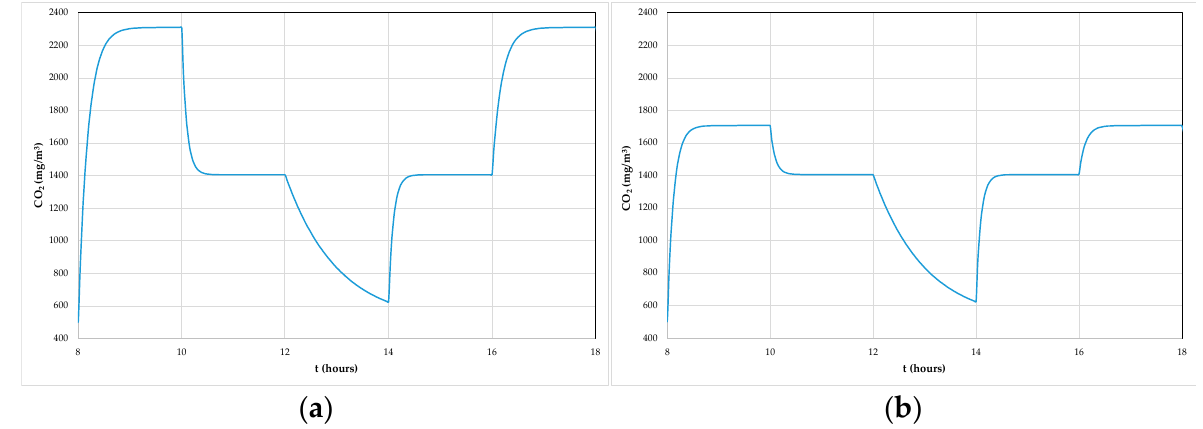
Figure 10. Evaluation of carbon dioxide (CO 2 ) concentration for Case G ( a ) and Case H ( b ).